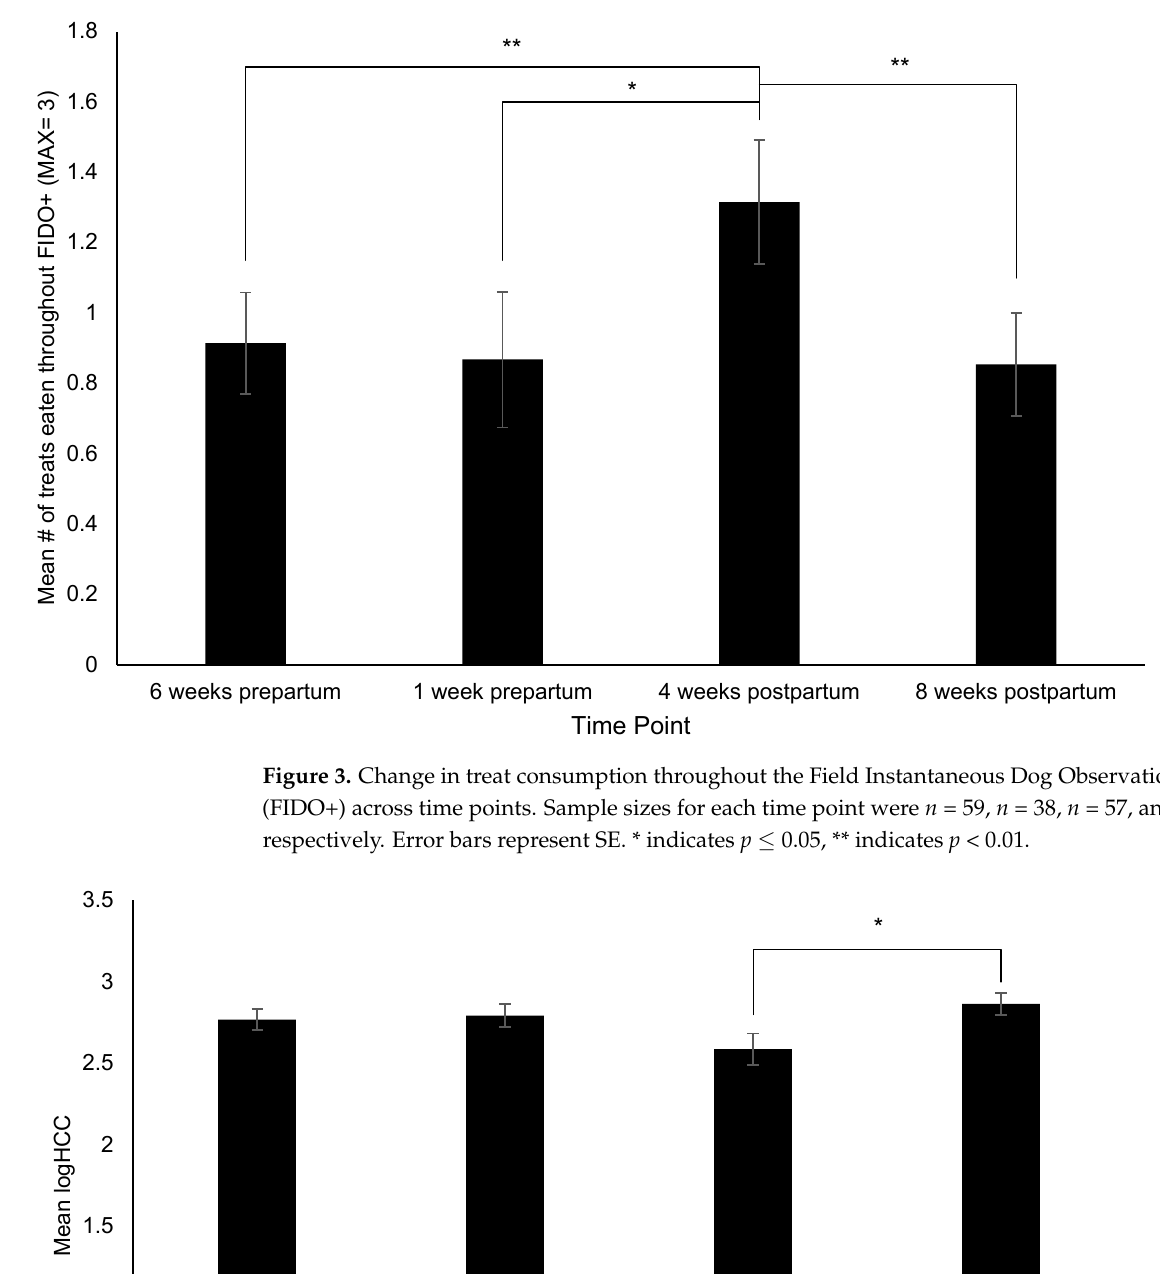
Figure 4. Change in hair cortisol concentration (logHCC) across time points. Sample sizes for each time point were n = 59, n = 43, n = 41, and n = 53, respectively. Error bars represent SE. * indicates p ≤ 0.05.